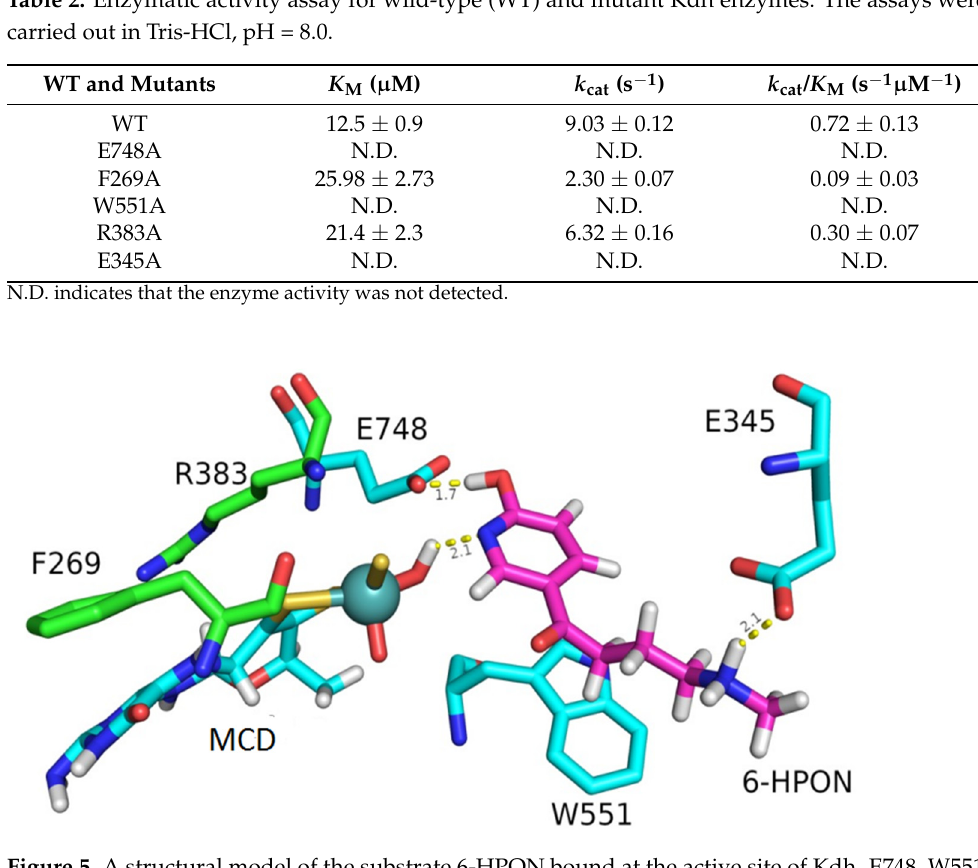
Table 2. Enzymatic activity assay for wild-type (WT) and mutant Kdh enzymes. The assays were carried out in Tris-HCl, pH =